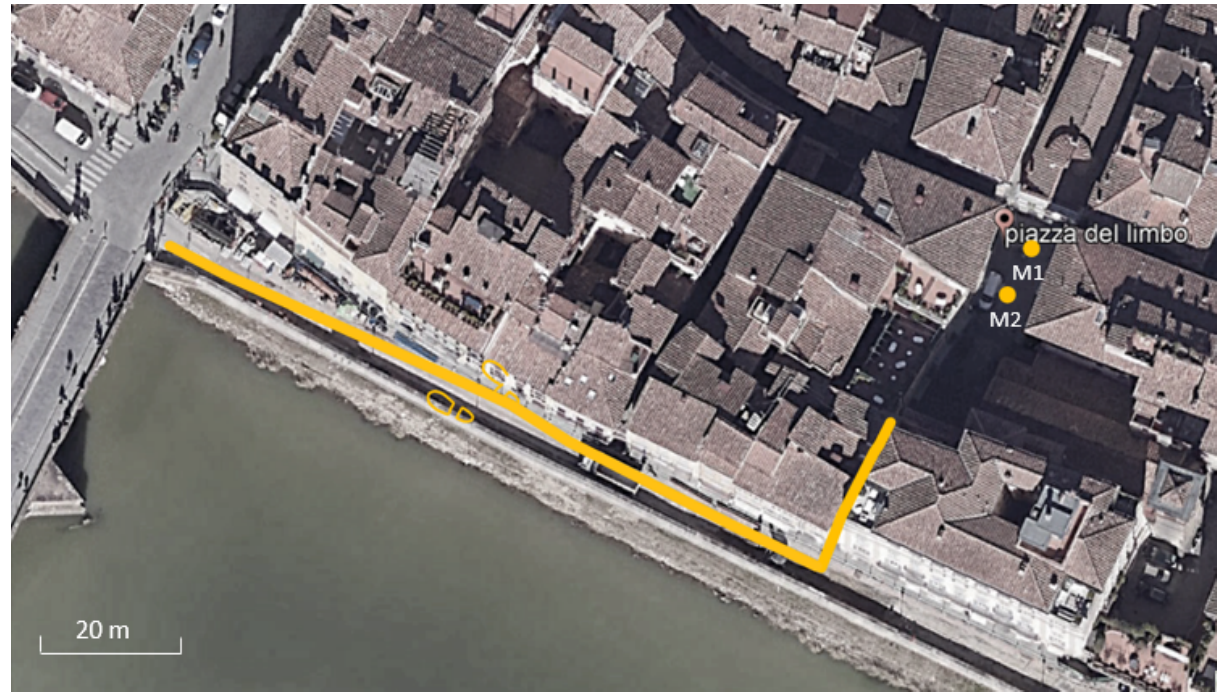
Figure 3: Example of the soundwalk’s path from and to the potential restorative area and of the spot measurement points inside the